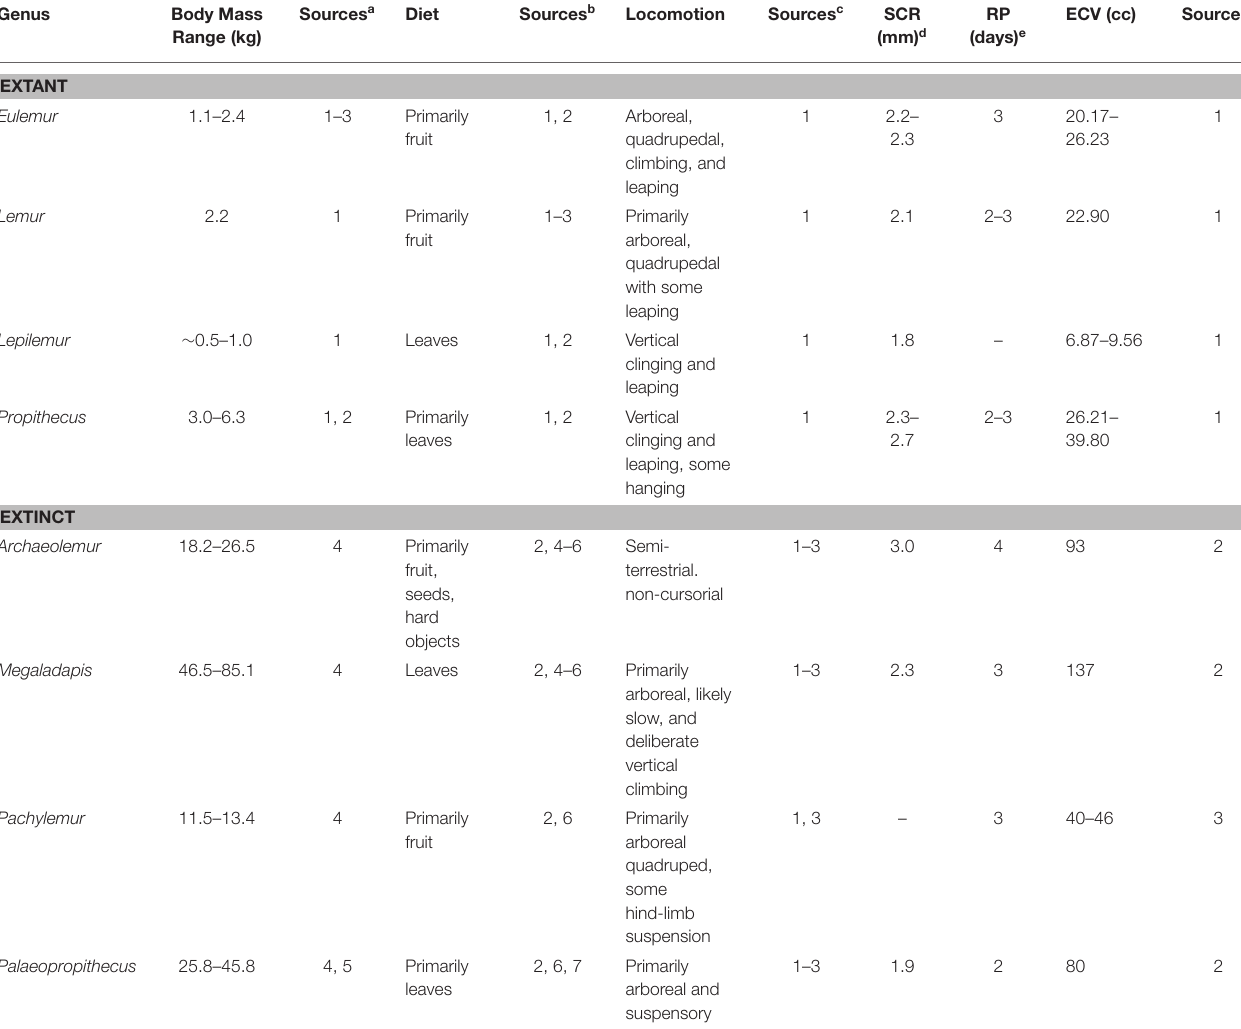
TABLE 1 | Body mass, diet, and locomotion, for taxa included in this